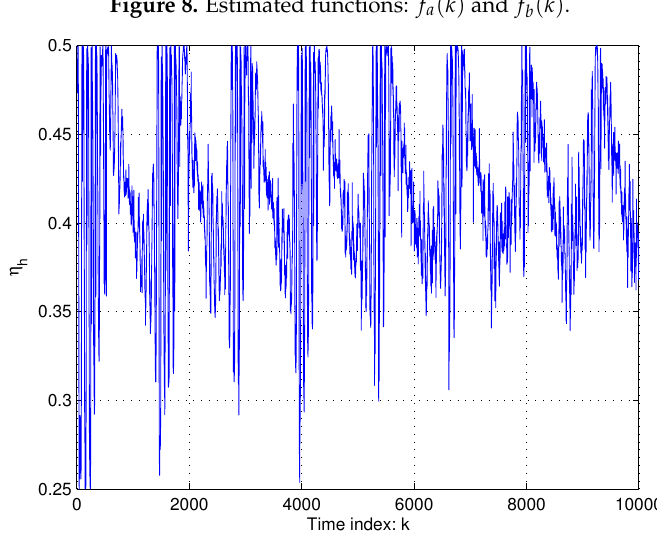
Figure 8. Estimated functions: ˆ f a ( k ) and ˆ f b ( k ) .